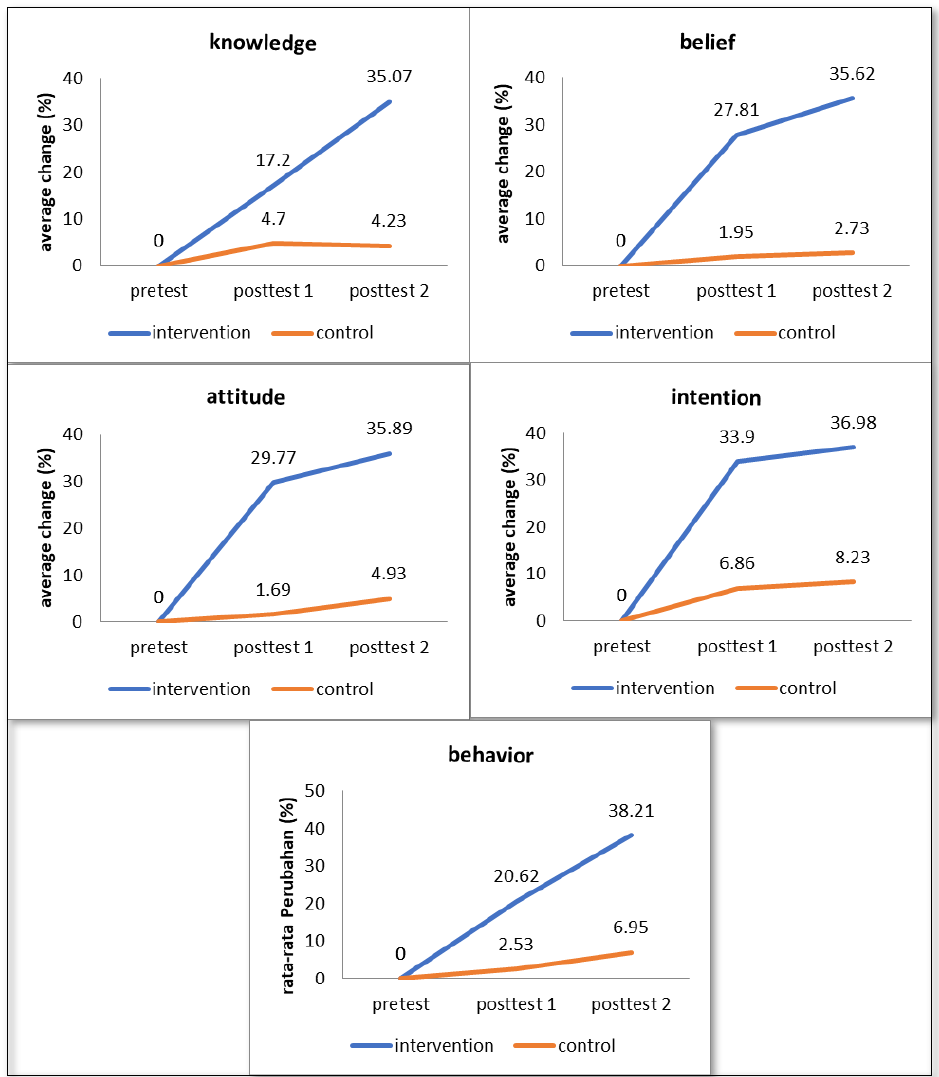
Figure 3. Partial analysis results.